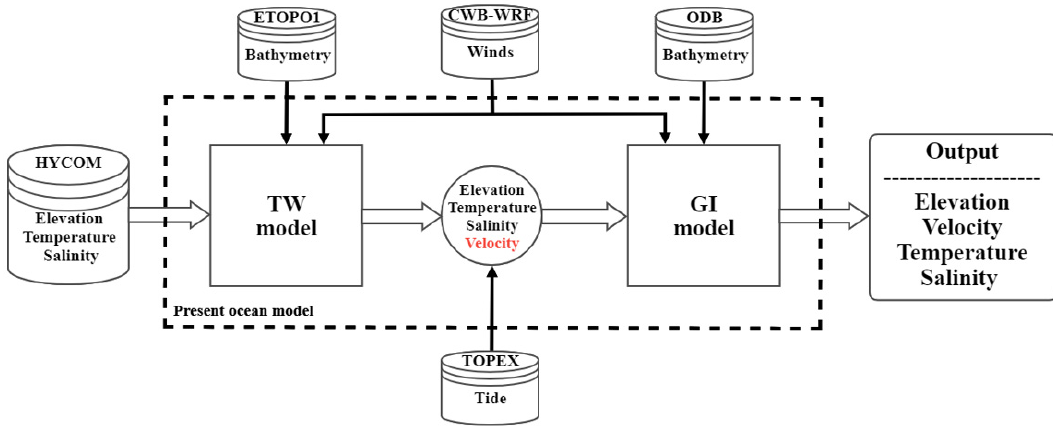
Figure 3. The driving forces of the present